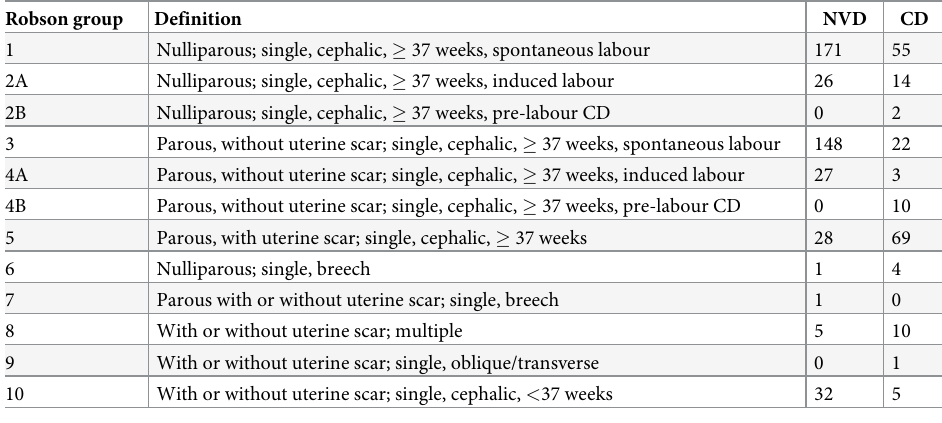
Table 3. Robson groups—Definitions and frequencies.